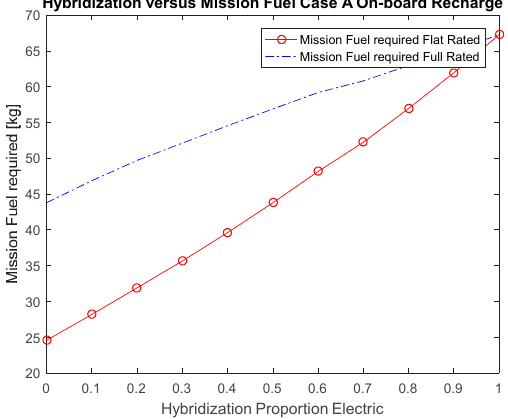
Figure 7. On-board ICE recharge mission fuel required, assuming no charge time limit.